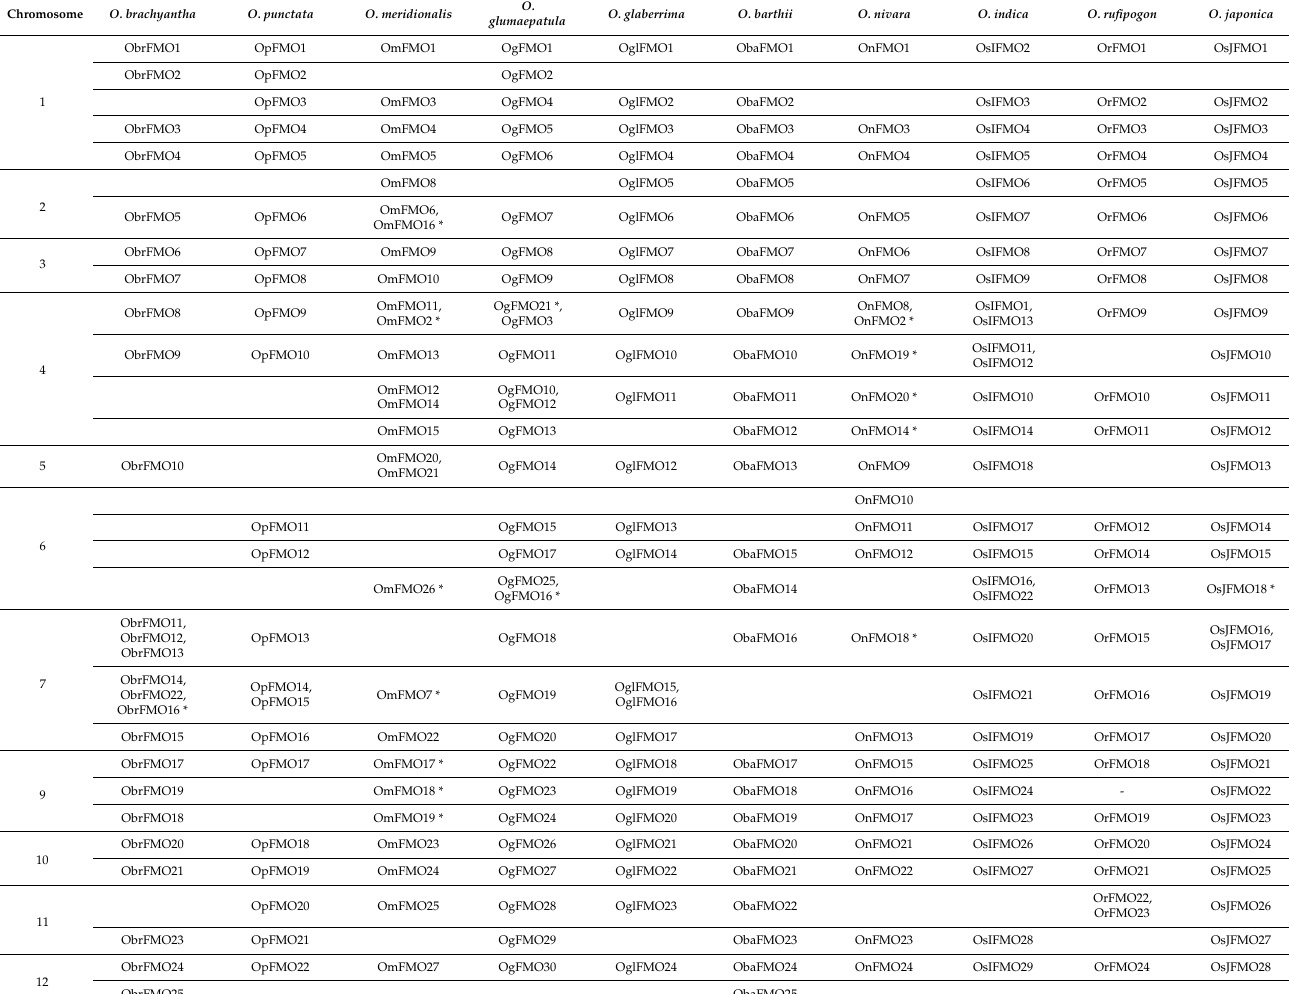
Table 2. Distribution of FMO genes in 10 genomes of rice. The chromosome-wise distribution of the identified FMO family members in the genomes of ten Oryza species, arranged according to their evolutionary history. O. brachyantha is the most distant and O. sativa subp. japonica is the most recent among these species. Each row contains list of genes that are orthologs of each other in different Oryza species. The blank space denotes the absence of the corresponding ortholog in the respective species. * Indicates the presence of an ortholog that belongs to some different chromosome in a particular